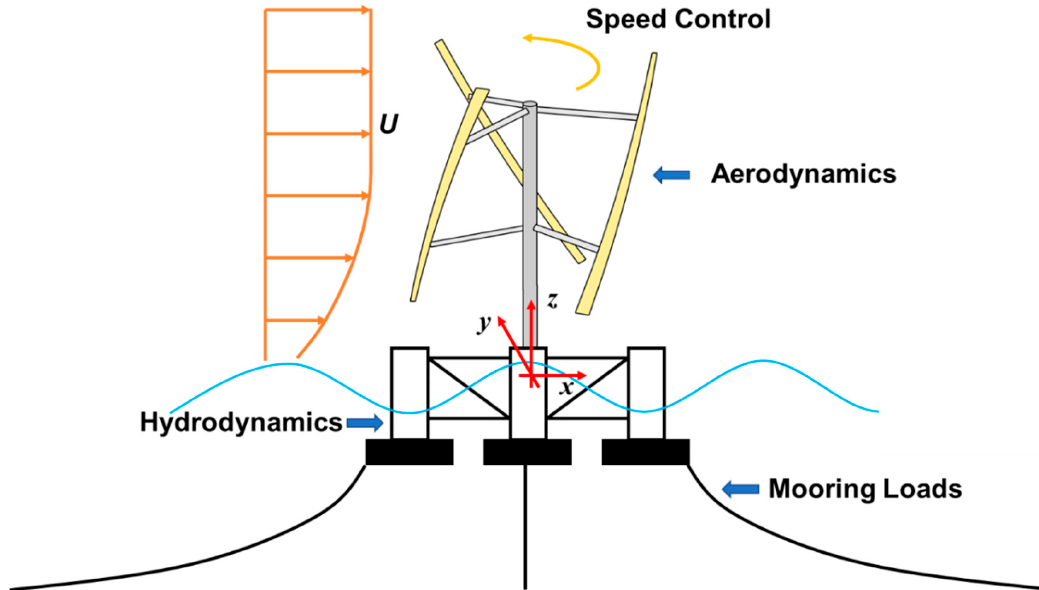
Figure 1. Definition of the physical problem.